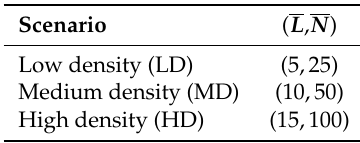
Table 2. ANs/RNs density scenarios.